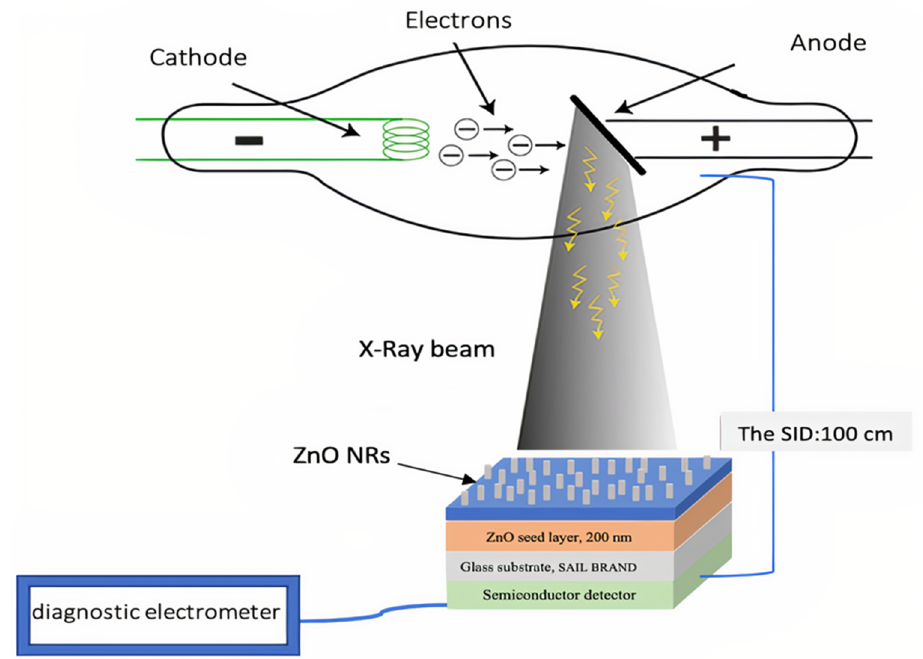
Figure 9. Schematic diagram of Experimental Setup.